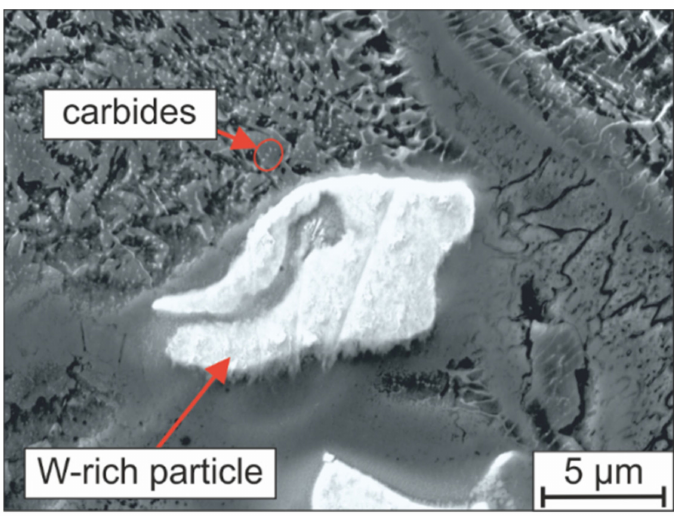
Figure 16. Microstructure of H-MIX in the surroundings of a W-rich